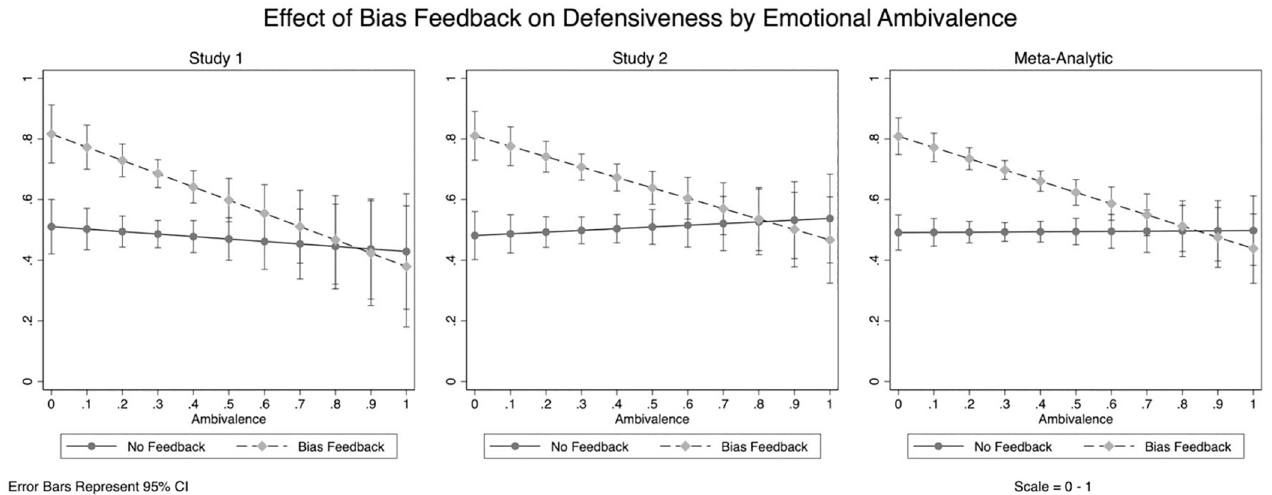
Fig 1. Effect of bias feedback on defensiveness by emotional ambivalence. (A) Study 1: The effect of feedback condition on defensive responding as a function of emotional ambivalence (B) Study 2: The effect of feedback condition on defensive responding as a function of emotional ambivalence (C) Meta- Analytic Analysis: The effect of feedback condition on defensive responding as a function of emotional ambivalence.